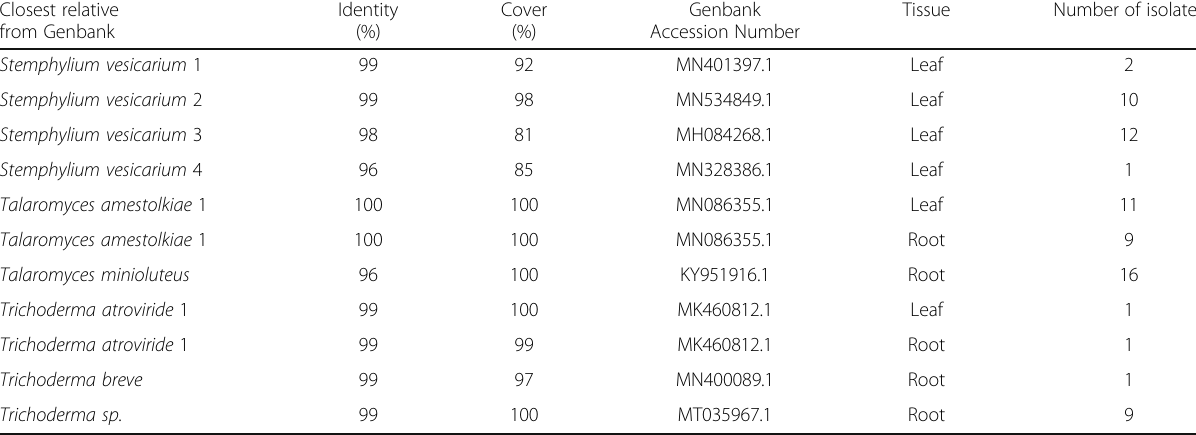
Table 1 Identified fungal endophyte species for leaf and root tissues of Aristolochia chilensis . The total number of isolates (considering the total individuals) for each OTU is indicated (Continued) Closest relative from